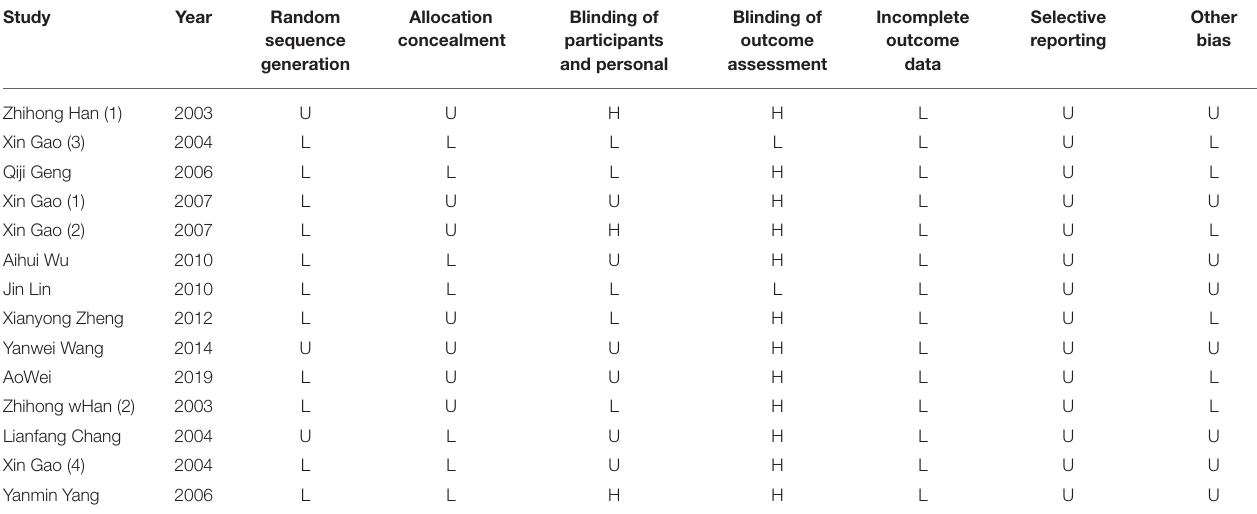
TABLE 2 | Risk of bias assessment.